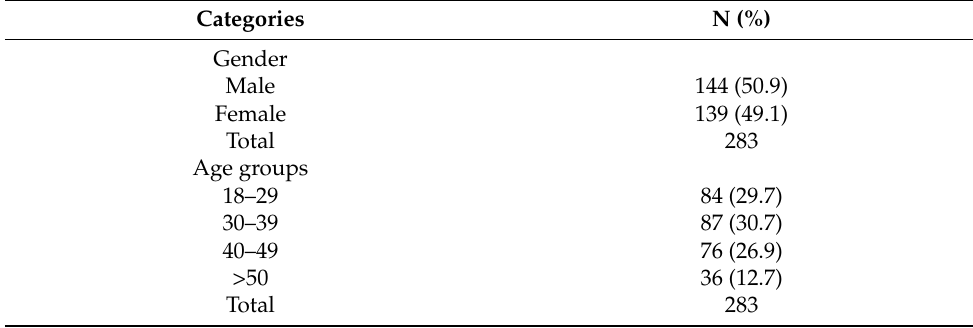
Table 1. Demographic characteristics for study participants (n =